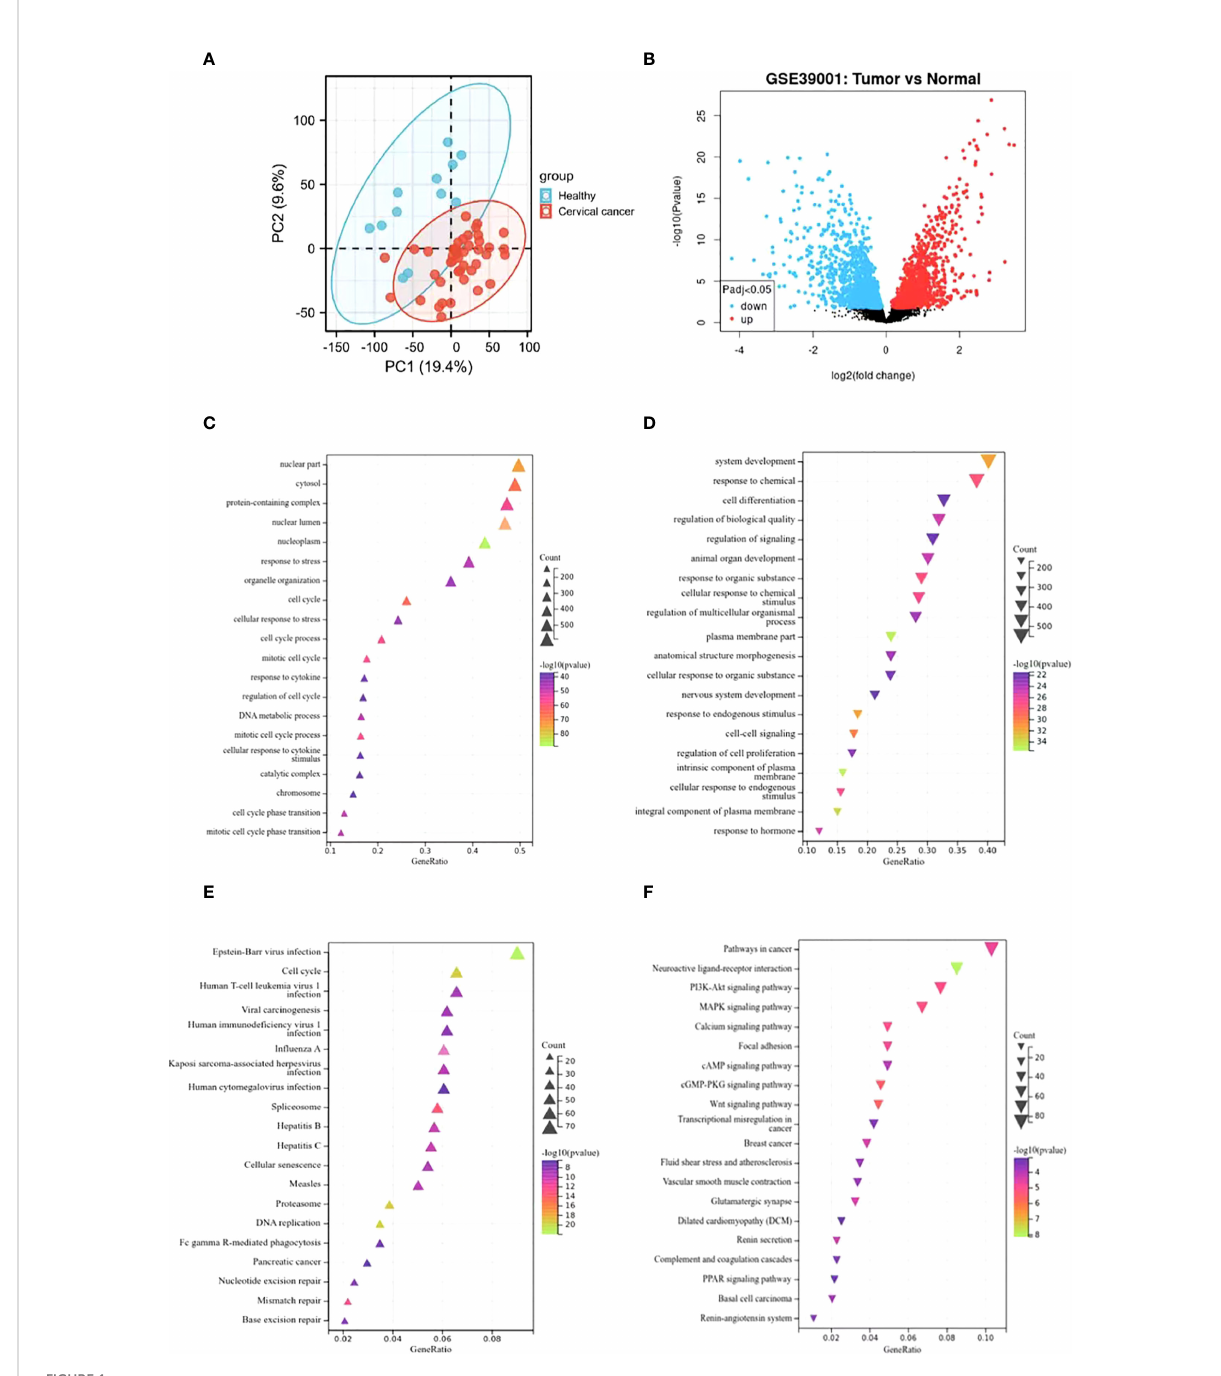
FIGURE 1 Identi fi cation of DEGs in GSE39001 and functional enrichment analysis. (A) Principal component analysis for GSE39001. (B) Volcano plot of the 2,859 DEGs. The red dots represent the signi fi cantly up-regulated genes, and the blue dots the signi fi cantly down-regulated genes. (C, D) GO analysis of high and low expression DEGs, respectively. (E, F) KEGG analysis of high and low expression DEGs,